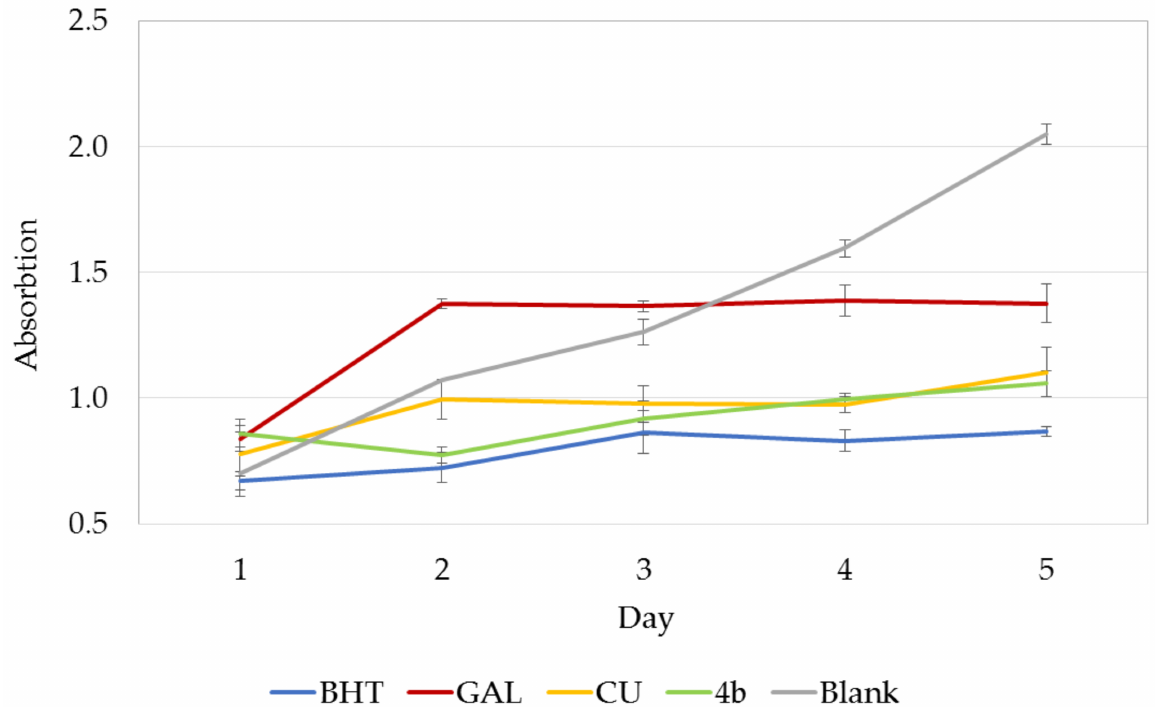
Figure 4. LPO inhibitory activity of GAL, CU and 4b monitored for 5 days. Absorbance is given in mean ± standard deviation ( n = 3). BHT is used as a positive control, MeOH as a